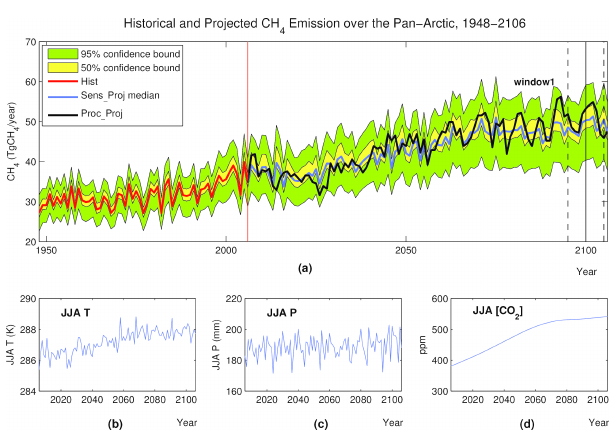
Figure 10. Historical and projected annual methane emissions and climate drivers over the pan-Arctic from 2007 to 2106. Panel (a) : sensitivity- and process-based projections (blue and black, respec- tively) of methane emissions from northern wetlands during 2007– 2106, with historical simulation (red) 1948–2006. Parameter-based uncertainties in the sensitivity-based projection are plotted as the yellow and green envelopes (50 and 95% confidence bounds, re- spectively); panels (b–d) : climate conditions for projections. The end-of-century window for time slice analysis (2096–2105) is de- noted with vertical solid and dashed lines in (a)